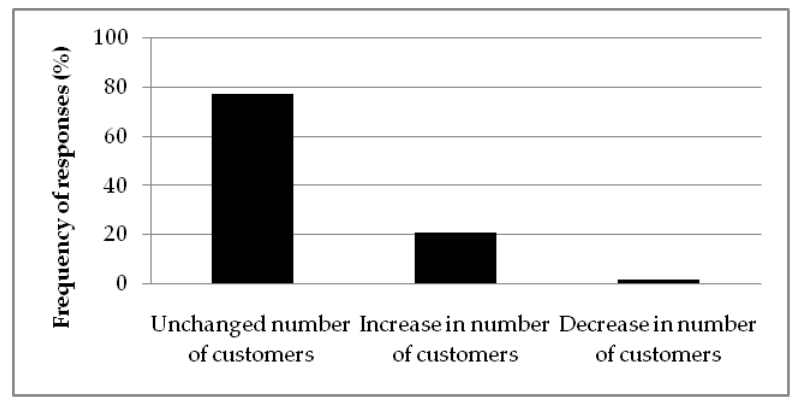
Figure 9. Perception of FDs FSC responsible persons regarding the impact of FSC certification on the number of customers (Question: What happened with the number of clients after certification of your FD?) (in Supplementary)